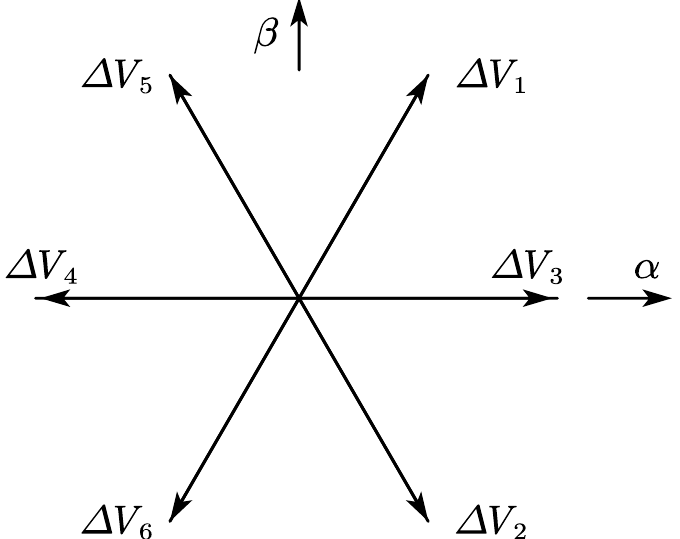
Figure 4. Six error voltage vectors differ by 120° from each other.